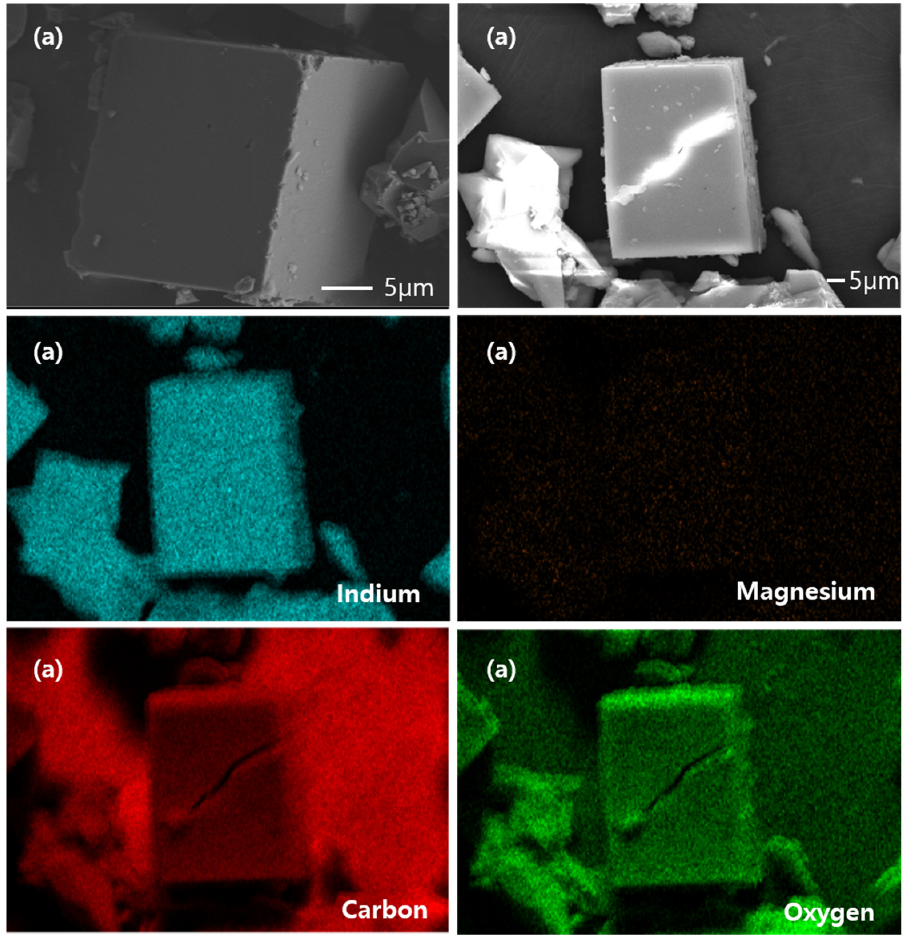
Figure 2 show SEM-EDS images of the synthesized CPM-200-In and CPM-200-In/Mg samples. The SEM images reveal that both CPM-200s have cubic like structures. As a result of EDS mapping, only In metal was observed in CPM-200-In, while In and Mg metals are well distributed in CPM-200-In/Mg. The FT-IR spectra of the catalysts are shown in Figure 3. The broad peaks in the range of 3400–3450 cm − 1 are assigned to the O-H stretching frequency of coordinated water. The big peaks at 1635 and 1430 cm − 1 correspond to the symmetric and asymmetric stretching vibration modes of the COOH group. The symmetric stretching vibration of the In-O and Mg-O bond at 419 cm − 1 and 548 cm − 1 verifies the coordination of metals with the ligands